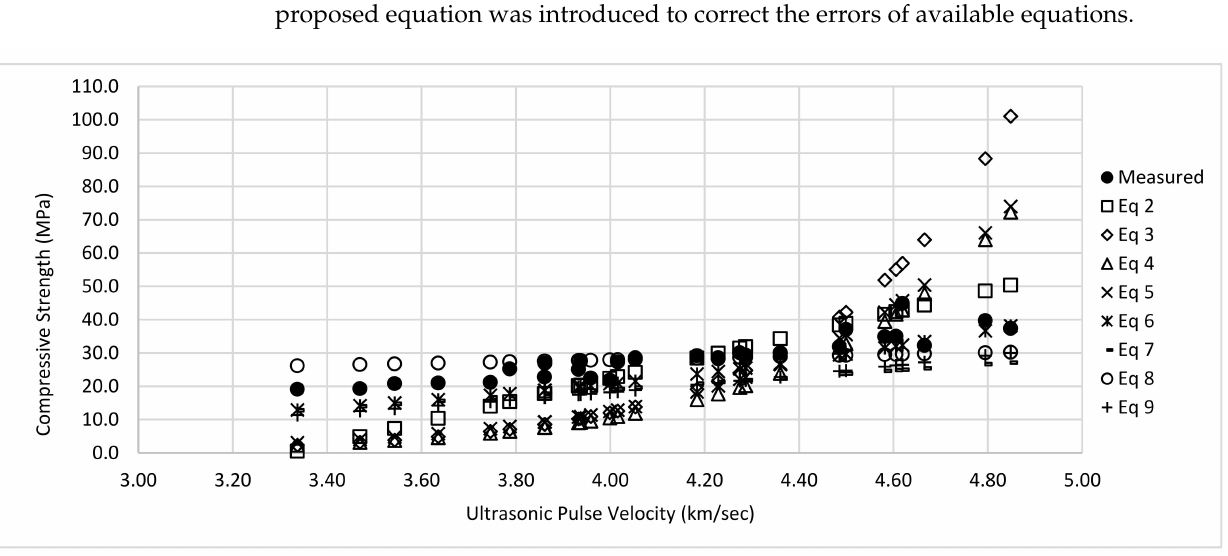
Figure 4. Measured compressive strength (CTM) vs. calculated compressive strength (all equations) for PFRC specimens.